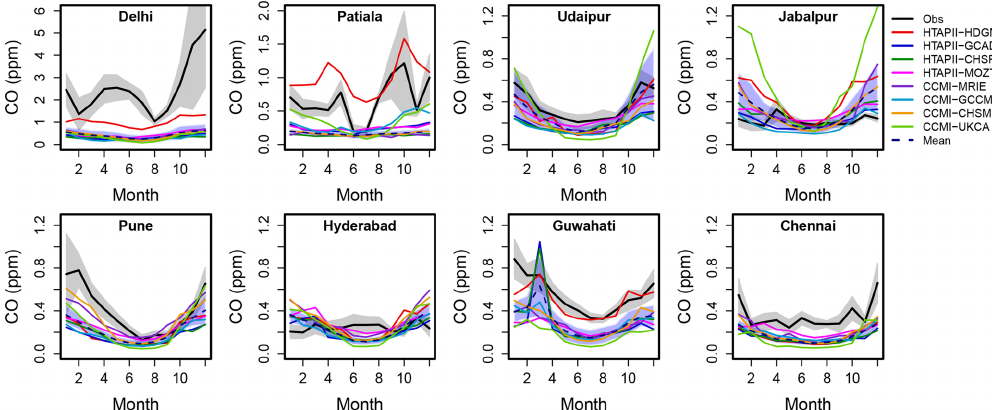
Figure 9. Comparison between ground-based observations and model simulations of monthly mean surface CO over the eight MAPAN stations. A different scale has been used for